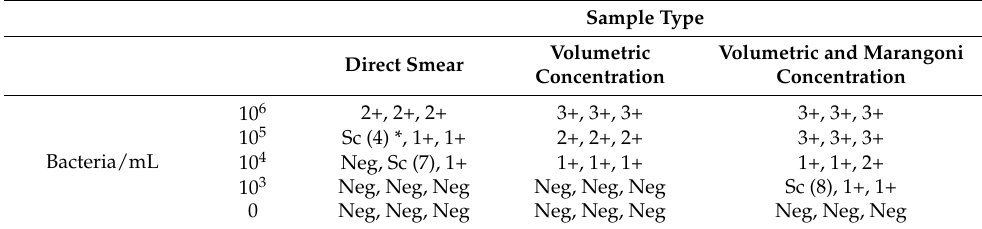
Table 2. Semi-quantitative grading for each sample processing